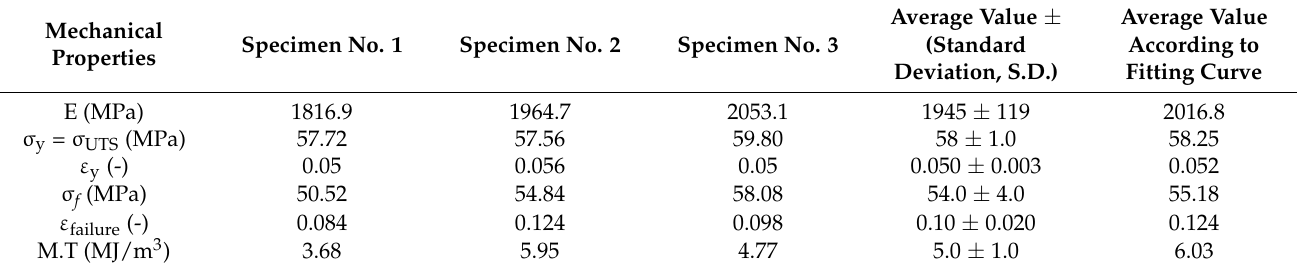
Figure 9. Average engineering stress–strain curves for solid, rectangular, diamond, and hexagonal infill test specimen configurations based on three tensile test specimens. A comparison of the tensile properties of various infill shapes was made and is pre ‐ sented in Figure 10a–f. It can be viewed from Figure 10a that the rectangular and hexagon infilled samples produced consistently higher modulus values. The hexagon infill exhib ‐ ited the highest value compared to the other three infill configurations and the value was approximately 64% greater than a solid sample. However, the reported modulus value of “generic PLA” is about 2780 MPa by using conventional testing injection molding [37]. Established by these explanations, it can be determined that the PLA produced by using the 3D printed technique is more elastic than that produced by more conventional tech ‐ niques. This will drastically improve the fracture toughness values of the 3D printed in ‐ fills. Generally, a very good entanglement of polymer chains was observed for injection molding, due to high pressure that results in strong and stiff samples. Furthermore, dur ‐ ing the mold filling process, asymmetrical flow is maintained inside the barrel due to ele ‐ vated temperature that helps to increase the modulus of the specimen. On the contrary, the bottom and top filaments usually do not perfectly attach and bond with each other in